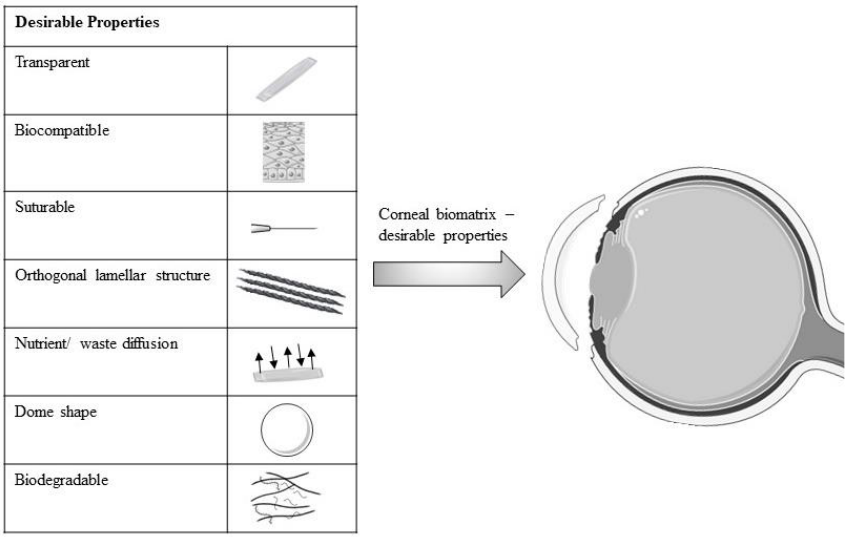
Figure 2. Schematic diagram of desirable properties of modified biomatrix for corneal engineering. Figure 2 was partly generated using Servier Medical Art, provided by Servier, licensed under a Cre- ative Commons Attribution 3.0 unported